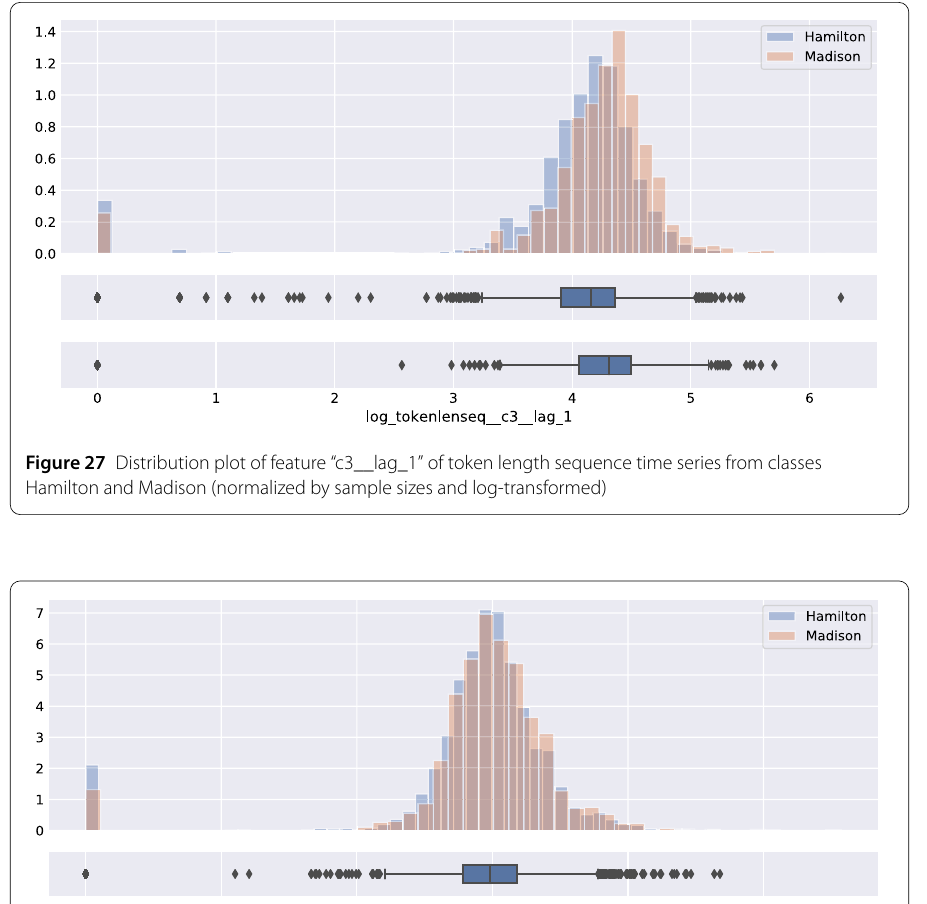
of three consecutive points in the token length sequence. The distributions of the